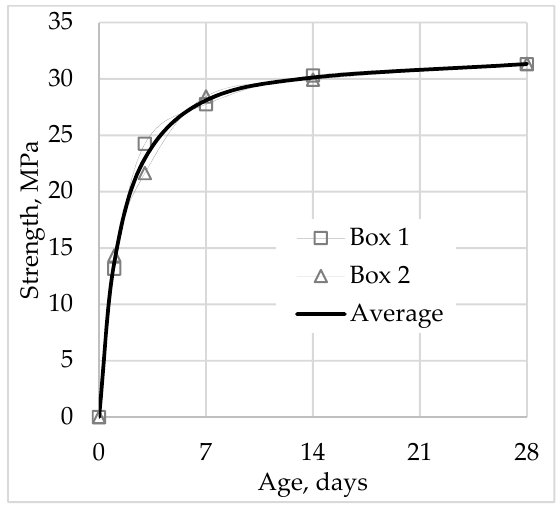
Figure 9. Strength of concrete in boxes measured by IPS-MG 4.01 sclerometer. Table 5. Results of strength tests determined by various methods.